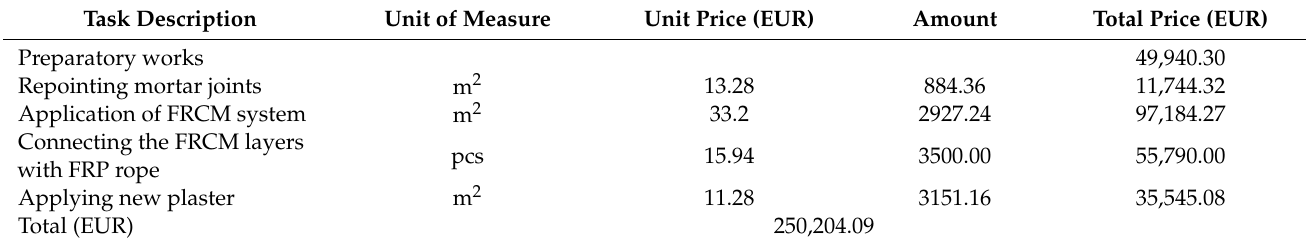
Table 10. Calculation of renovation costs—FRCM composite